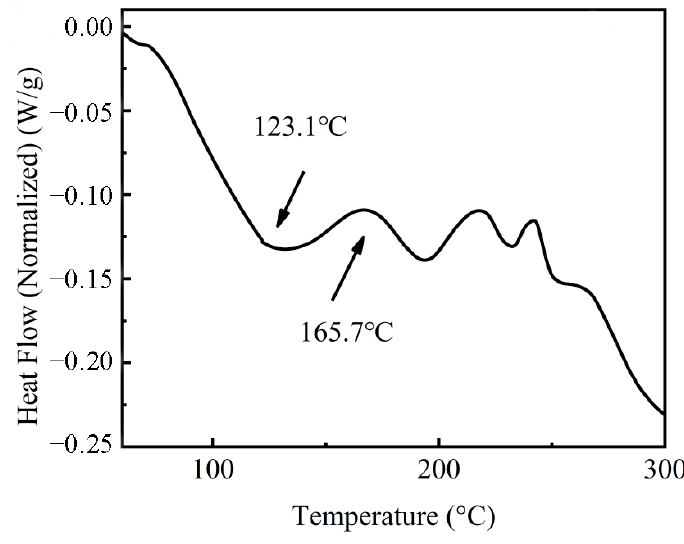
Figure 7. DSC curve for the solid solution.